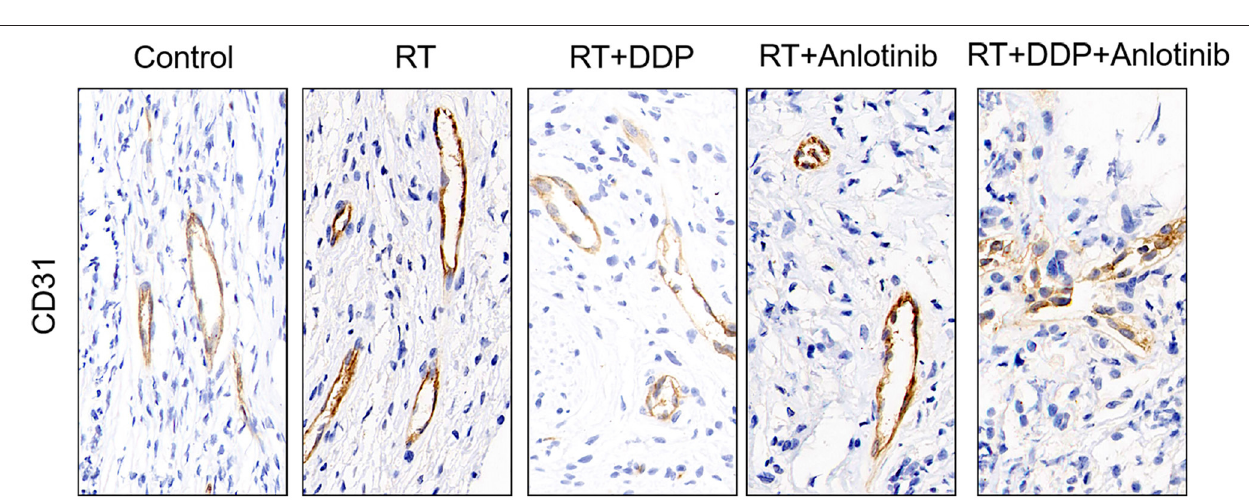
FIGURE 11 | Representative images during treatment showed that the vascular structures in the control group retained their normal shape. However, the vessels showed pucker, and the vascular structures were damaged to different extent in the four treatment groups where the anlotinib combined with chemoradiation-treated group exhibited the most significant change. The figure provided is a representative image, and other images are provided in the Supplementary Files. RT, radiation therapy; DDP,